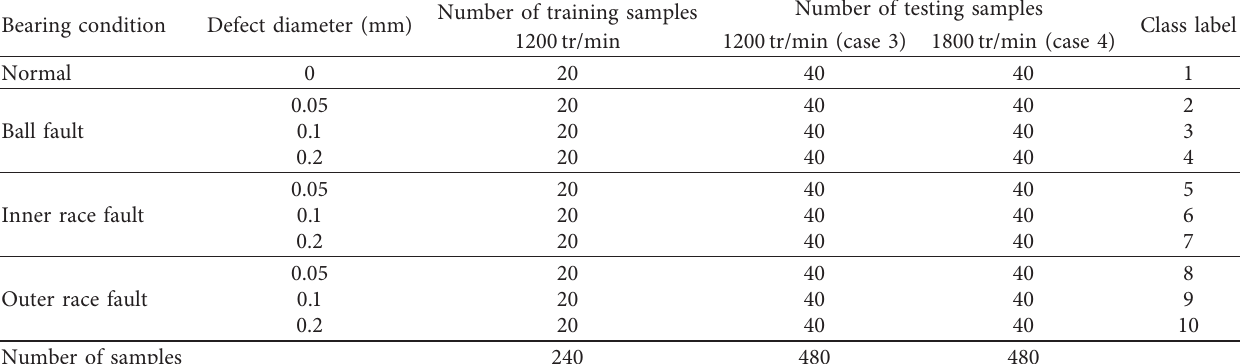
Table 18: The detailed information of the second group dataset.